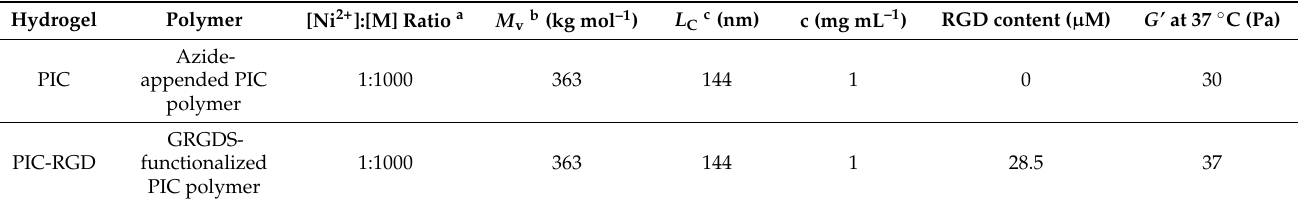
Figure 1. Structure and mechanical properties of PIC hydrogels. ( A ) Chemical structure of PIC-RGD; the GRGDS peptide is functionalized onto the side chain of PIC via a SPAAC reaction between azide and DBCO, 3.3% of the total monomers are appended with N 3 , and 1% of the total monomers is functionalized with GRGDS. ( B , C ) Thermoresponsive behavior of PIC. The temperature ramps show that PIC gelates upon heating with a transition temperature between 15–20 ◦ C ( B ) and liquefies once the temperature declines below the gelation point ( C ). ( D , E ) The fibrous architecture revealed by fluorescence imaging (( D ), scale bar =10 µ m) and cryoSEM (( E ), scale bar = 0.5 µ m). Table 1. PIC hydrogels used in the current study.